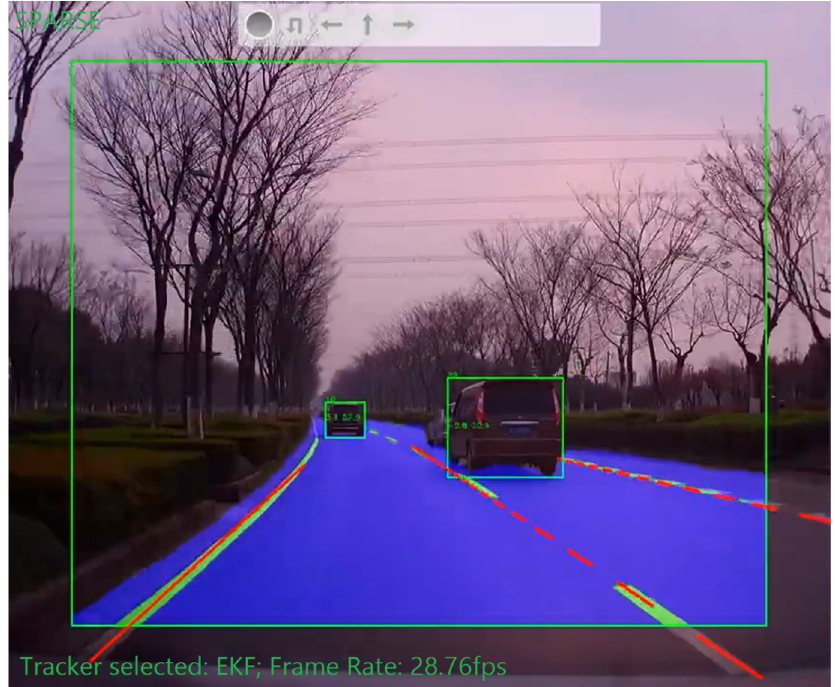
Figure 20. Image taken at t = 13.89 s. Traffic state: Sparse. Tracker: EKF.